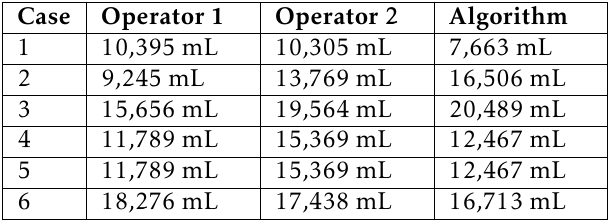
Table 3. Volumes of CSF obtained by